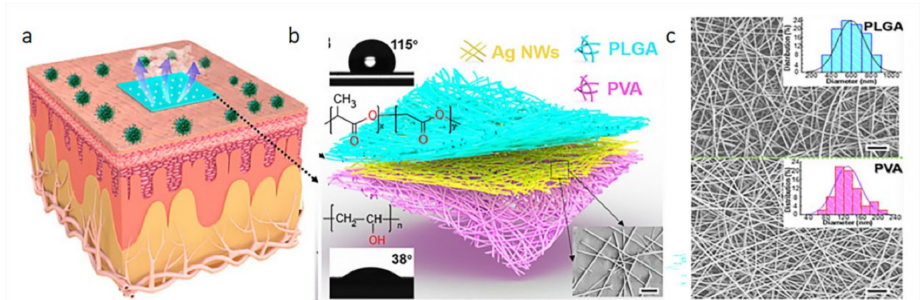
Figure 11. Schematic diagram of electronic skin and its scanning electron micrograph. ( a ) The electronic skin is attached to the epidermis; ( b ) electronic skin structure diagram; ( c ) SEM image of the upper and lower layers of material